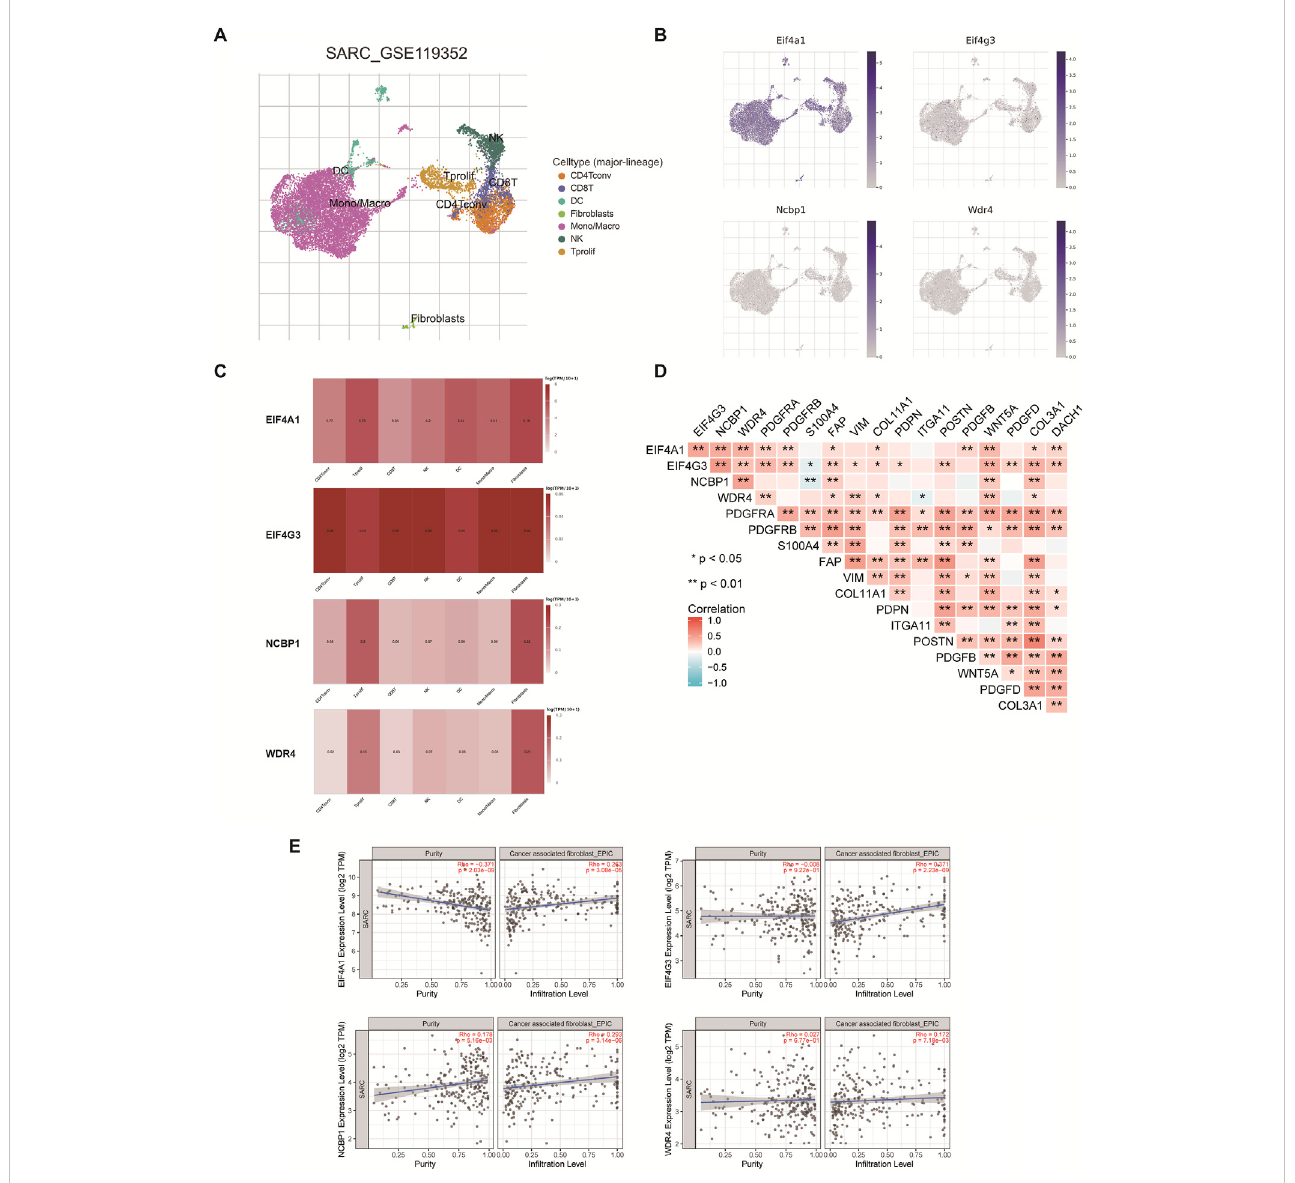
FIGURE 11 The expression of m7GRGs in different immune cell types in sarcomas. (A) Cluster diagram of cell types in scRNA seq data. t-SNE diagram showing the expression of different immune cells (SARC_GSE119352_mouse_APD1aCTLA4) in sarcoma tissues; (B, C) Characteristic maps of prognostic m7GRGs obtained from scRNA seq data; (D) Correlation between m7GRGs and CAF-related markers; (E) Correlation between prognostic m7GRGs and CAFs in fi ltration; Correlation analysis was completed by TIMER2.0; ** p < 0.01; Cancer associated fi broblasts